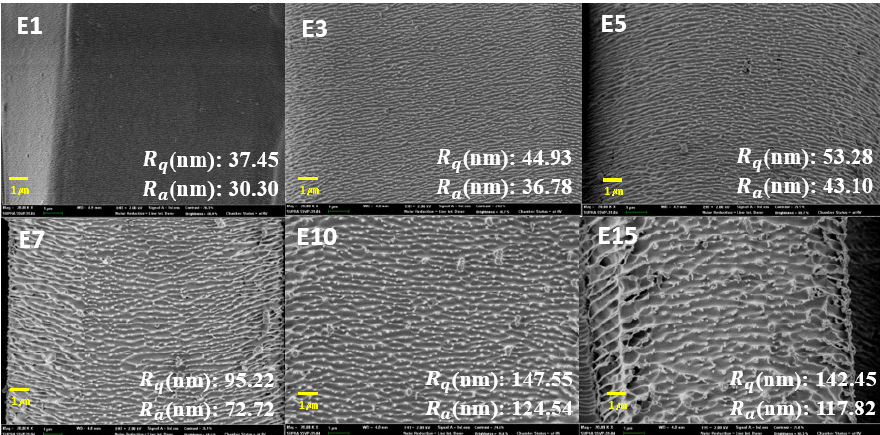
Figure 2. Results of scanning electron microscopy and atomic force microscopy of the plasma-etched specimens for 1, 3, 5, 7, 10, and 15 min, and their arithmetical mean deviation Ra and root mean squared Rq (magnification of × 20,000, scale bar: 1 μ m).